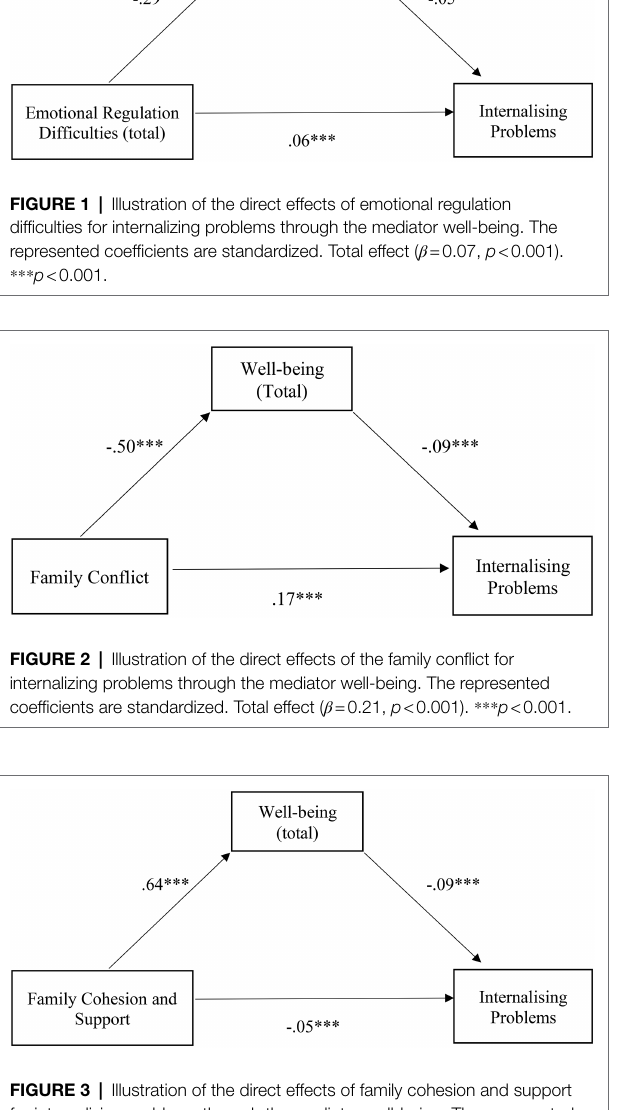
FIGURE 3 | Illustration of the direct effects of family cohesion and support for internalizing problems through the mediator well-being. The represented coefficients are standardized. Total effect ( β = − 0.11, p < 0.001). *** p <